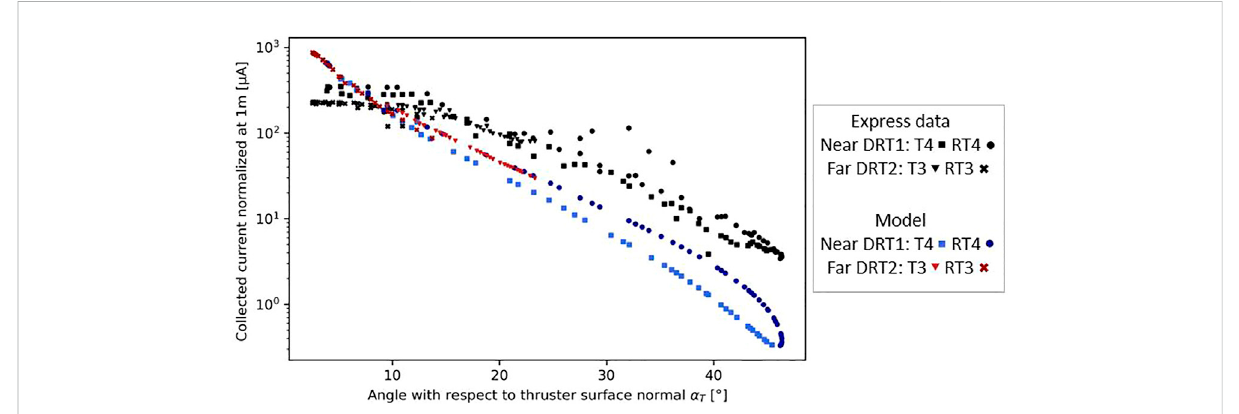
FIGURE 11 Collected current normalized at1 mfrom thethrusterusing a 1 / r 2 law as afunction ofthe fi ringangle. Comparison oftheprocessedExpress-A data and model results (using input IEDF from the hybrid Hall-thruster code). The near and far probes are, respectively, ‘ DRT1 ’ and ‘ DRT2 ’